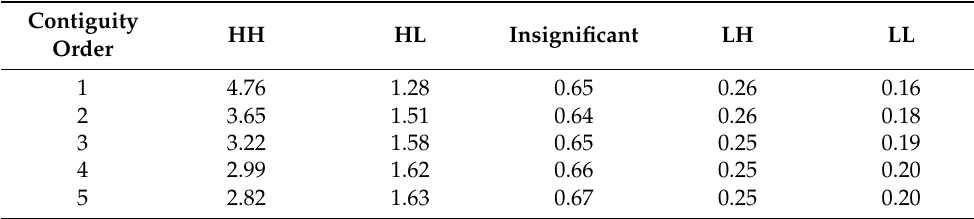
Table 2. Average value of the polarization index at the enumeration district scale by spatial clustering classification (HH: high–high, LL: low–low; LH: low–high; and HL: